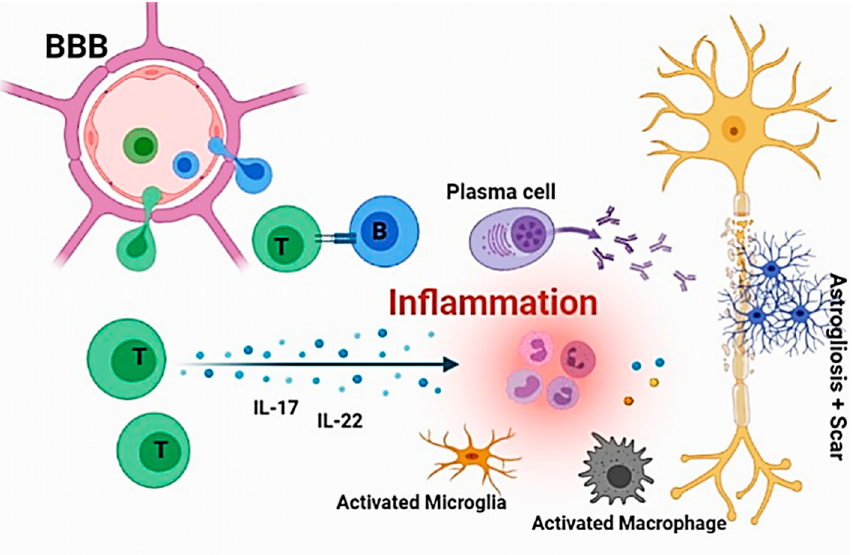
Figure 1. The initial immunopathogenesis of MS. A breakdown of peripheral T cell tolerance disrupts the blood–brain barrier (BBB) and leads to inflammation within the CNS resulting in the destruction of nerves.